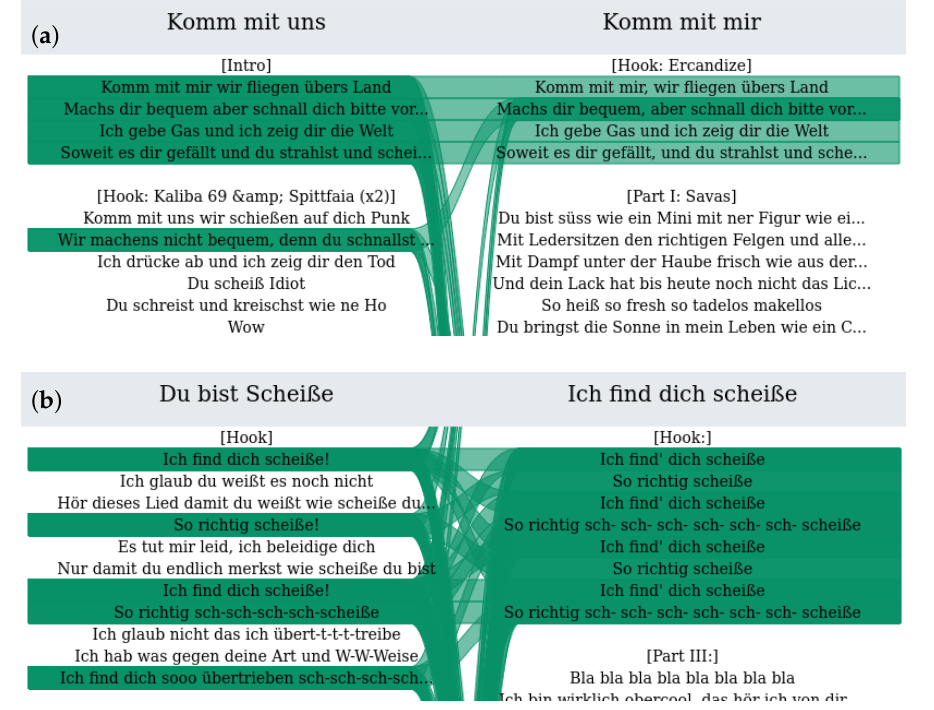
Figure 7. Monolingual alignments on the line level of the songs “Kool Savas-Komm mit mir” and “Alligatoah-Komm mit uns” ( a ), and “Sido-Du bist Scheiße” and “Tic Tac Toe-Ich find dich scheiße” ( b ).